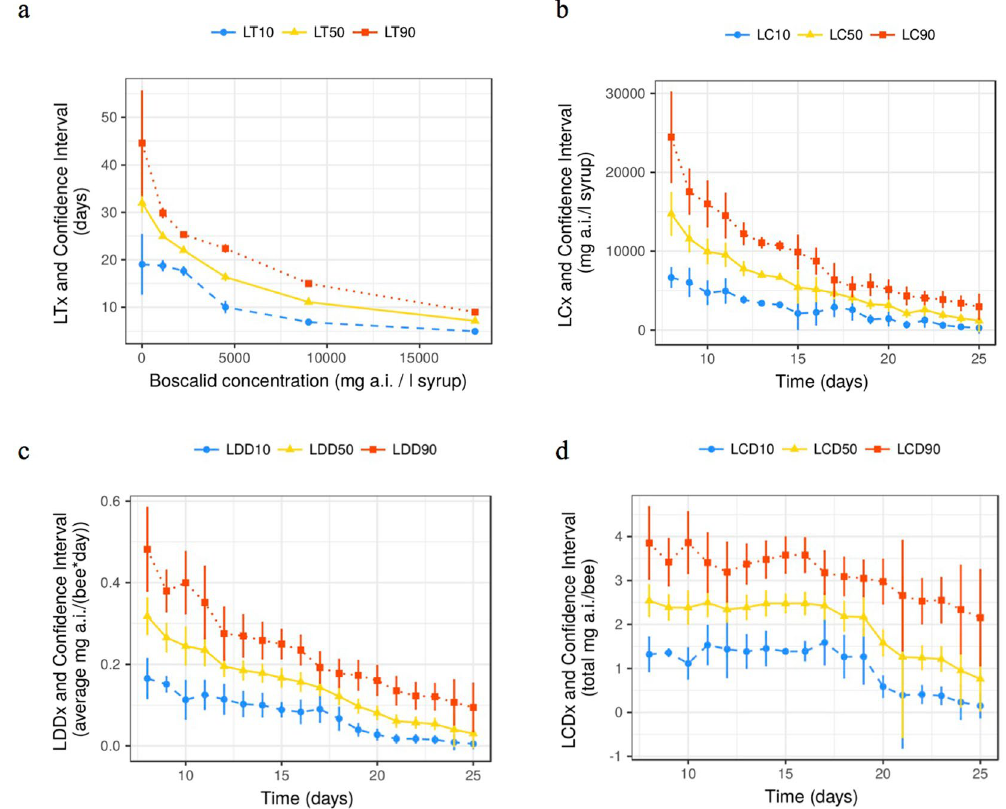
Figure 4. Representations of LTx vs. Concentration ( a ), LCx vs. Time ( b ), LDDx vs. Time ( c ) and LCDx vs. Time ( d ). All graphs represent the toxic endpoint for 10%, 50% and 90% mortality estimated with three parameters Weibull 2 models. See Table 1 for meaning of the abbreviations. See Suppl. Mat., “raw_results” directory to obtain the raw numbers used in these